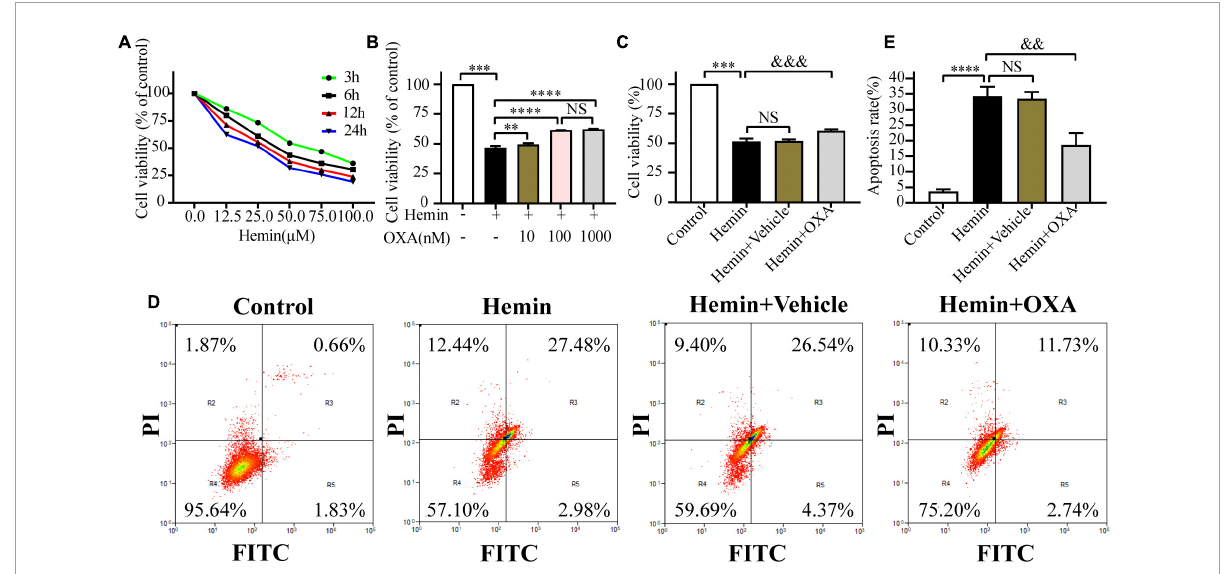
FIGURE4 Orexin-A relieves hemin-induced PC12 cells injury in vitro . (A) Survival curve of hemin-induced PC12 cells injury. (B) Effects of treatment with various concentrations of OXA on the hemin-induced decrease in the viability of PC12 cells. ∗∗∗ p < 0.001 vs. non-treated group; ∗∗ p < 0.01 and ∗∗∗∗ p < 0.0001 vs. hemin-treated group; NS, no- significant difference between the two groups. (C) OXA attenuates the hemin-induced decrease in cell viability. (D) OXA inhibited hemin-induced apoptosis. PC12 cells were divided into four groups, the effects of OXA on apoptosis were detected by flow cytometric, and representative FCM plots are shown. (E) Quantified results of the flow cytometric analysis. ∗∗∗ p < 0.001 and ∗∗∗∗ p < 0.0001 vs. the control group; NS, non-significant different compared to the hemin group. && p < 0.01 and &&& p < 0.001 vs. the hemin